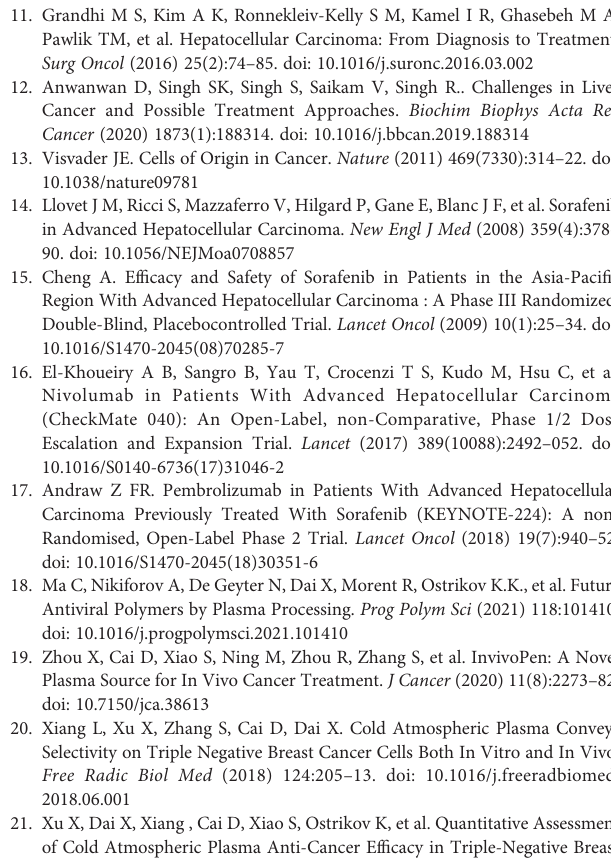
Supplementary Table 1 | Information on the siRNAs used in this study. Supplementary Table 2 | Information on primers used in this